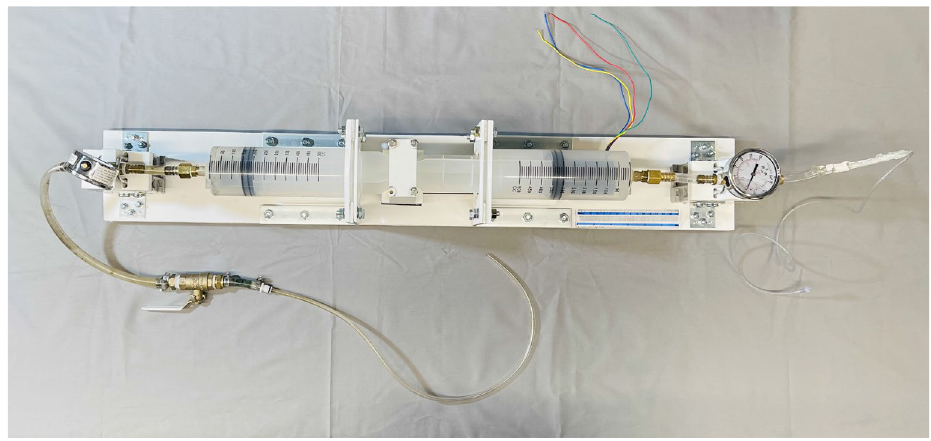
Figure 3. A top-down view of the linear actuator used in conjunction with the Hydra Catheter.